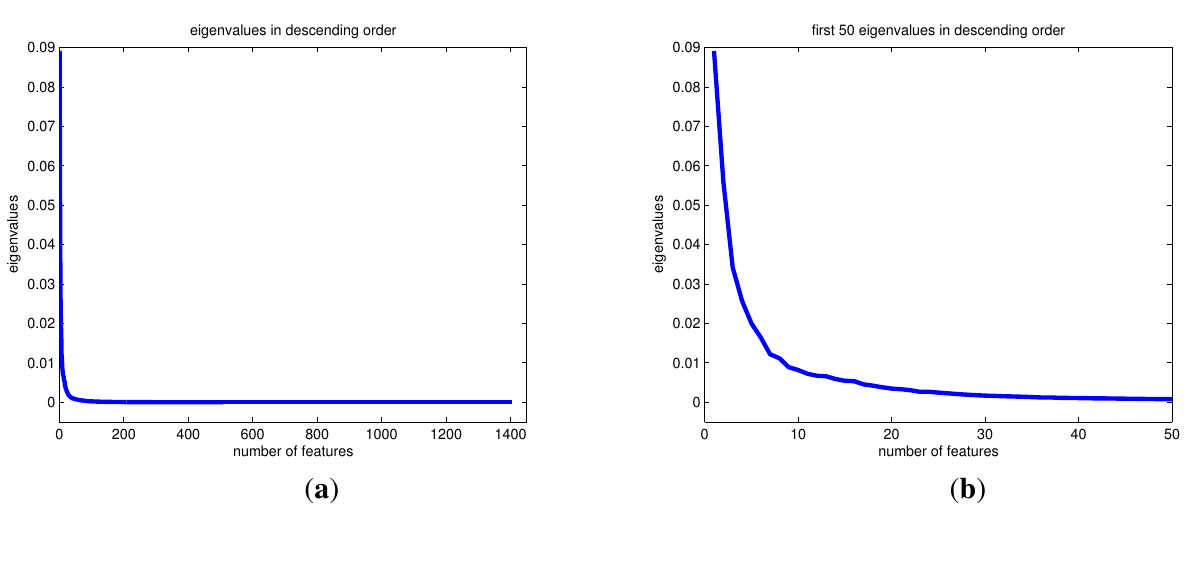
Figure 2. ( a ) All eigenvalues (1404) and ( b ) the first 50 eigenvalues of the covariance matrix sorted in descending